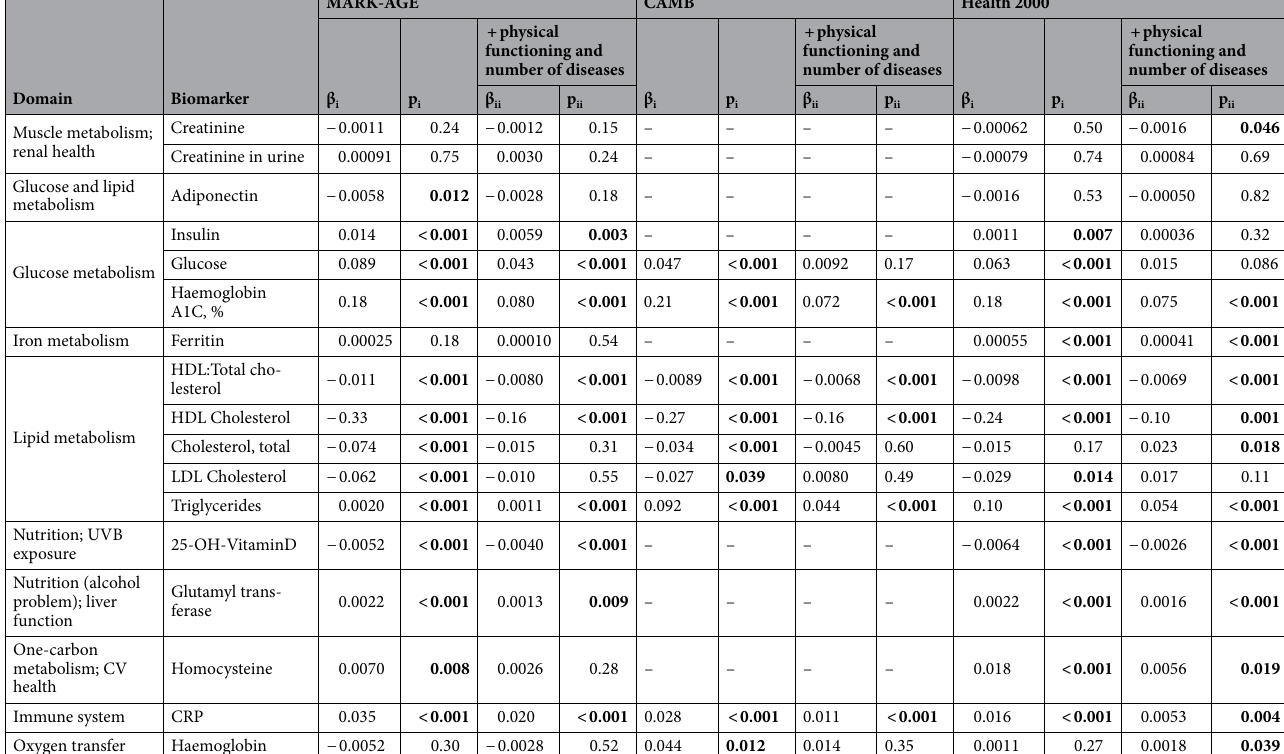
Table 2. Associations between biomarkers and SRH in linear regression analysis, adjusted for (i) age and gender and (ii) additionally for number of diseases and physical functioning. CRP C-reactive protein, the results for all biomarkers (n = 17) available in two or three data sets (MARK-AGE, CAMB, and/or Health 2000). Criteria for significant association of a biomarker was p < 0.05 in all data sets where it was analysed. p-values less than 0.05 are shown in bold. Results for all biomarkers are shown in Supplementary information